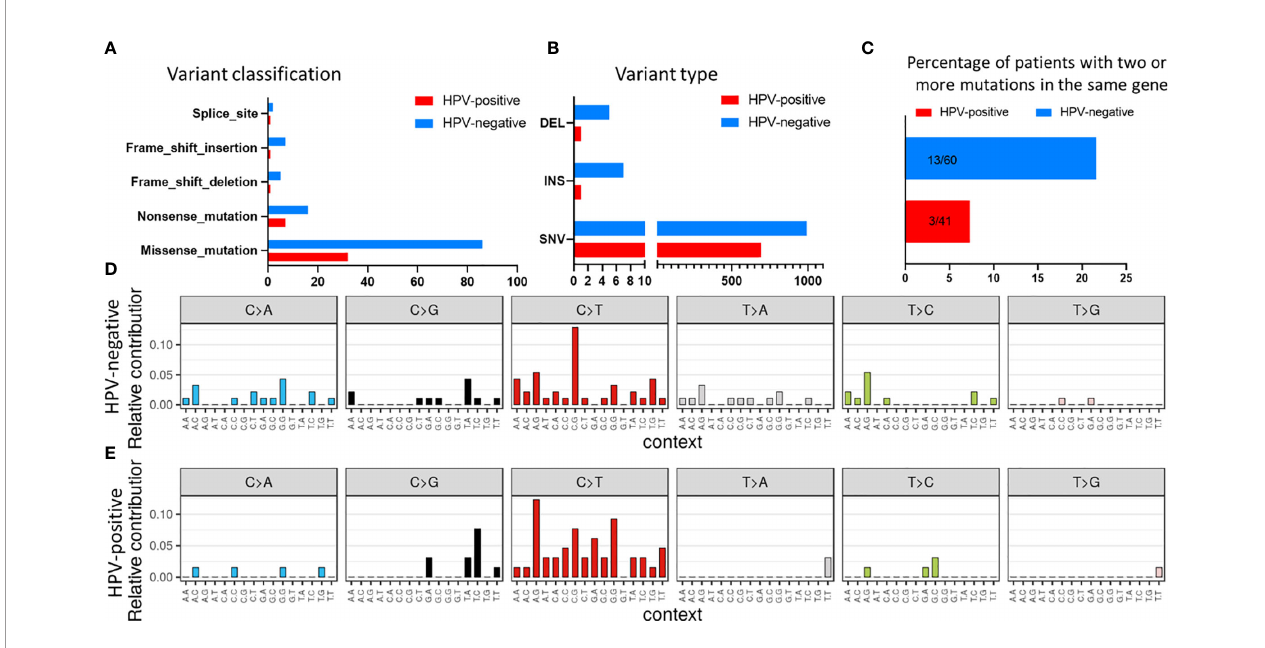
FIGURE 3 | Mutational signature in the HNSCC samples strati fi ed with respect to HPV status for (A) variant classi fi cation and (B) variant type. (C) Comparison of number of patients with two or more mutations in the same gene. Mutational pro fi le based on C:G>T:A transitions in (D) HPV-negative and (E) HPV-positive samples.